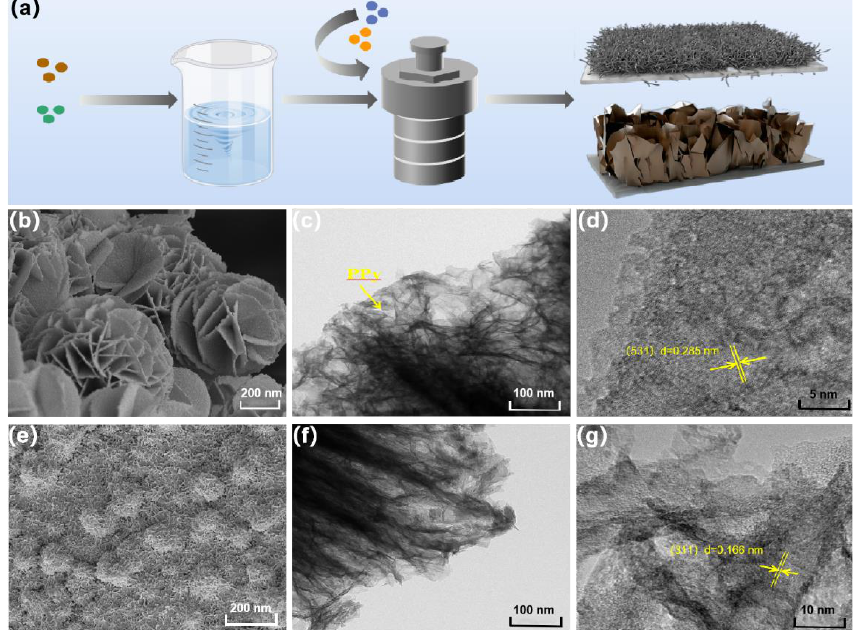
Figure 1. ( a ) Schematic illustrating the fabrication route of PPy@FeNi 2 S 4 @NF and PPy@NiCo 2 S 4 @NF. SEM images of ( b ) PPy@FeNi 2 S 4 , ( e ) PPy@NiCo 2 S 4 @NF. ( c , f ) TEM images of PPy@FeNi 2 S 4 @NF and PPy@NiCo 2 S 4 @NF. ( d , g ) High − resolution TEM image of PPy@FeNi 2 S 4 @NF and PPy@NiCo 2 S 4 @NF. The X − ray diffraction (XRD) patterns of PPy@FeNi 2 S 4 @NF and PPy@NiCo 2 S 4 @NF are